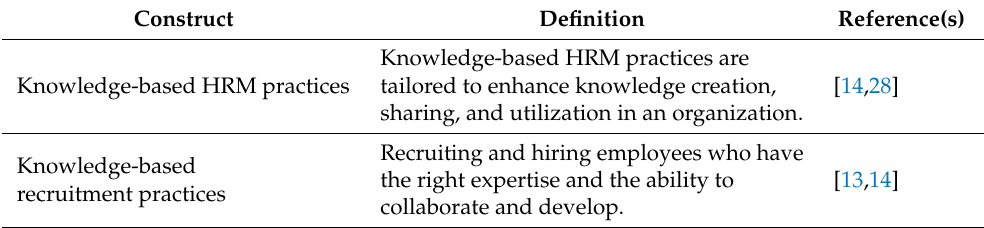
Table 1. Constructs and